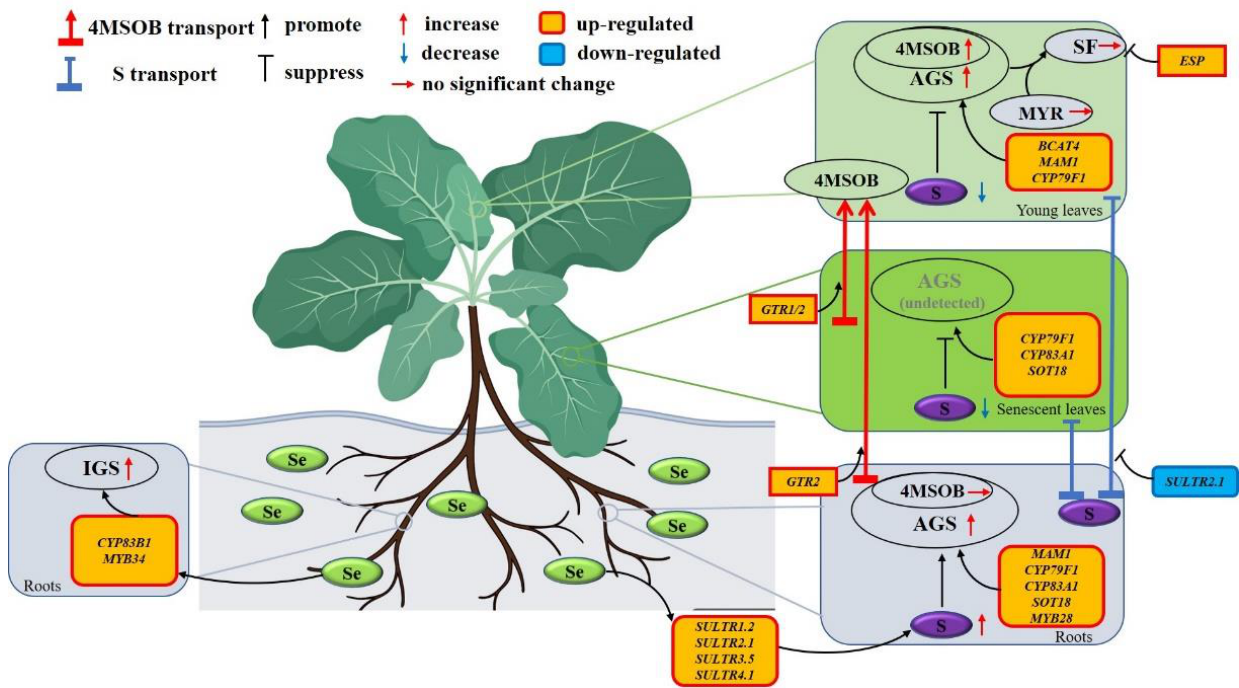
Figure 7. Model of Se-induced regulation of GSLs and 4MSOB contents in broccoli roots and leaves. Se, 50 μM Na 2 SeO 3 treatment; S, total sulfur; AGS, Met-derived GSLs; IGS, Trp-derived GSLs; 4MSOB, glucoraphanin; SF, sulforaphane; MYR, myrosinase activity. (We suggested the reader refer to the web version of this article to interpret the colors used in the figure legend.